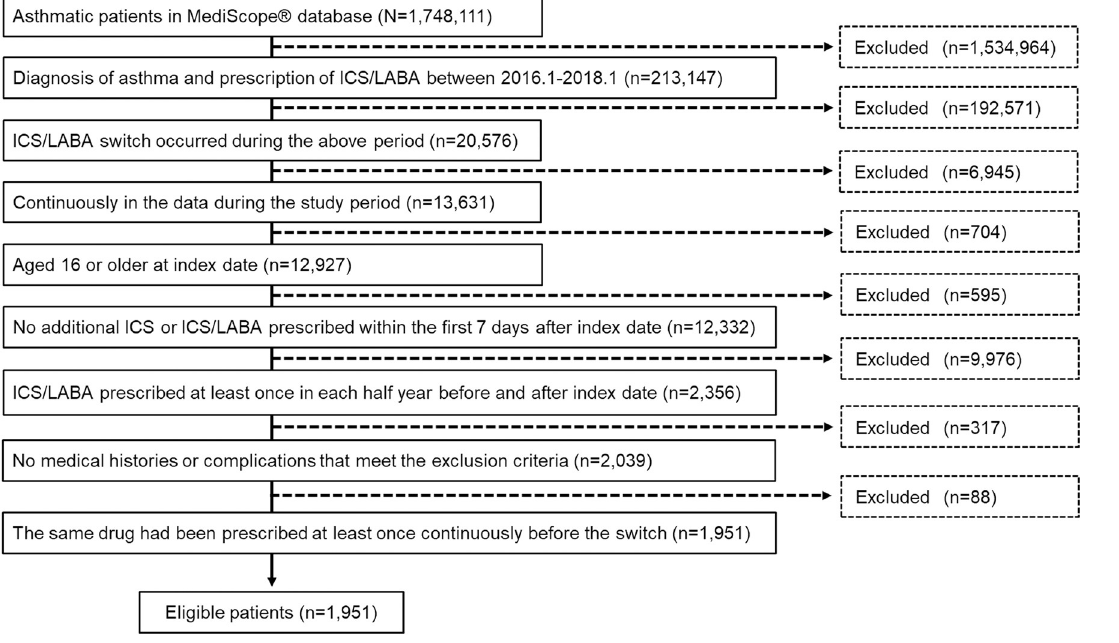
Fig 2. Flow of eligible patients. ICS, inhaled corticosteroid; LABA, long-acting β